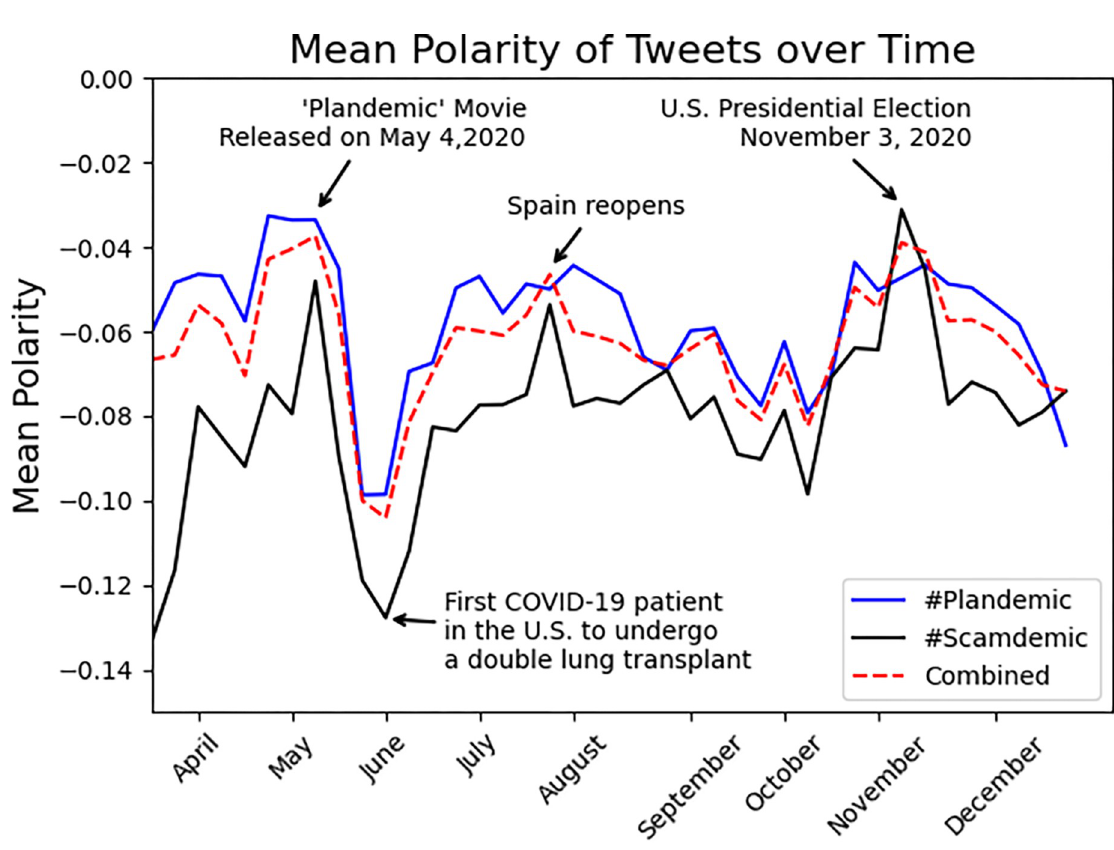
Fig 4. Mean polarity of #scamdemic and #plandemic tweets over time.